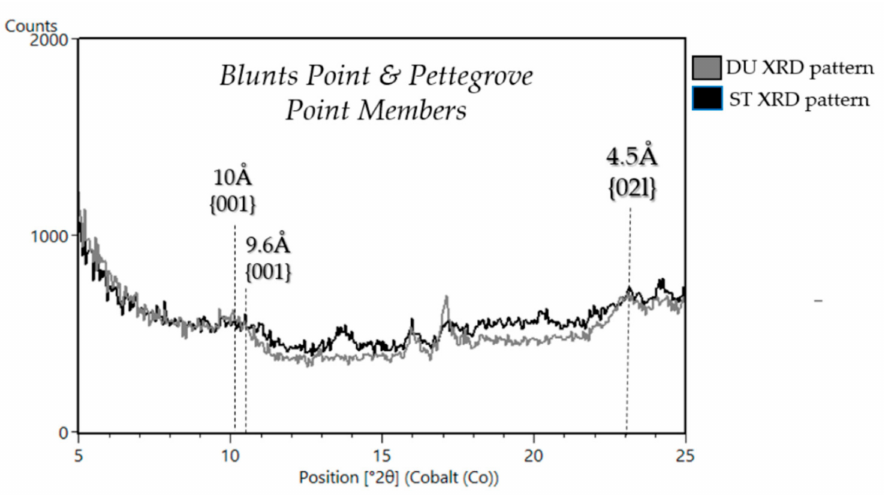
Figure 15. CheMin XRD patterns from 5 ◦ to 25 ◦ 2 θ of samples from the Blunts Point member (DU) and the Pettegrove Point member (ST). The position of the d(001) and d(02l) peaks are denoted by dashed black